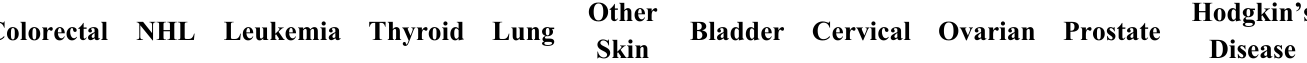
Table 4. Coefficients of determination (r²) derived from GWR